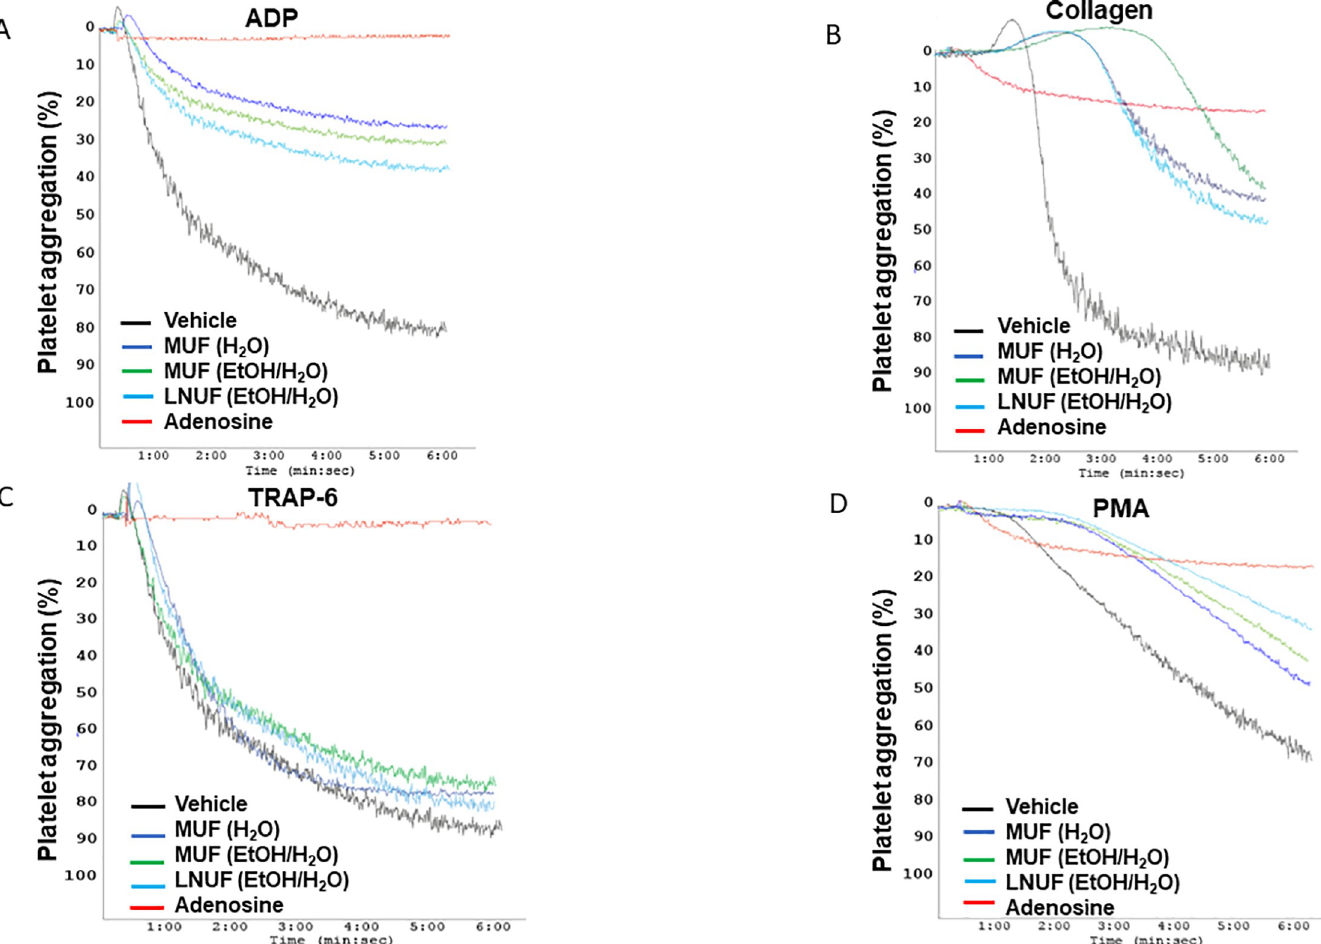
Fig 1. Platelet aggregation induced by different agonists is modulated by maqui extracts. Representative curves of platelet aggregation induced by ADP (A), collagen (B), TRAP-6 (C), and PMA (D). LNUF (EtOH/H 2 O): Ethanolic extract of Luna Nueva unripe fruit; MUF (H 2 O): Aqueous extract of Morena unripe fruit; MUF (EtOH/ H 2 O): Ethanolic extract of Morena unripe